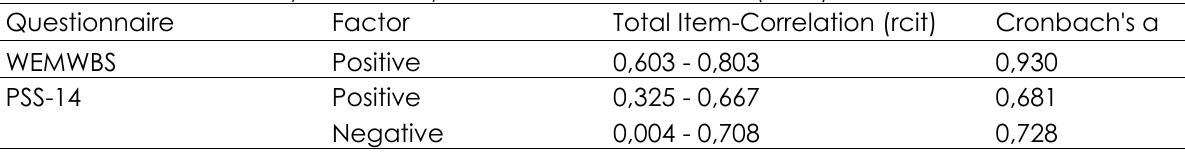
Table 2. The result of the Validity dan Reliability of the three measurement tools (n=192).